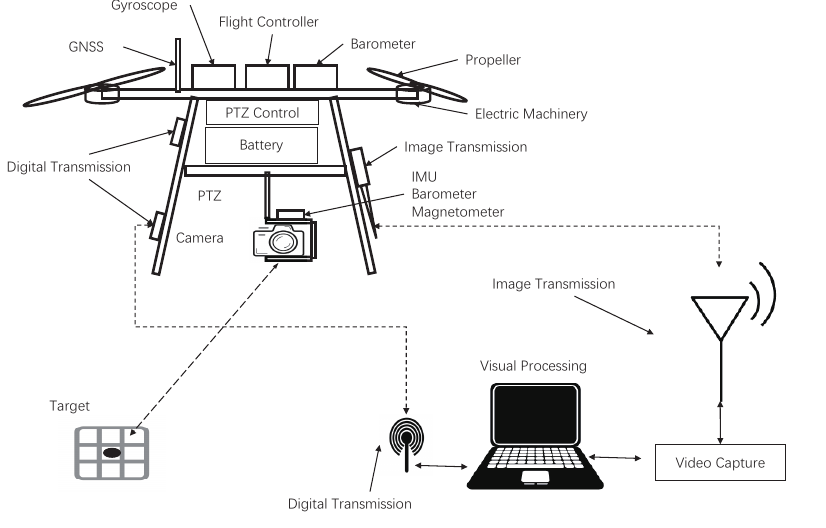
Figure 5. The experimental setup on multi-rotor